Question: Identify the chart type used in this figure.
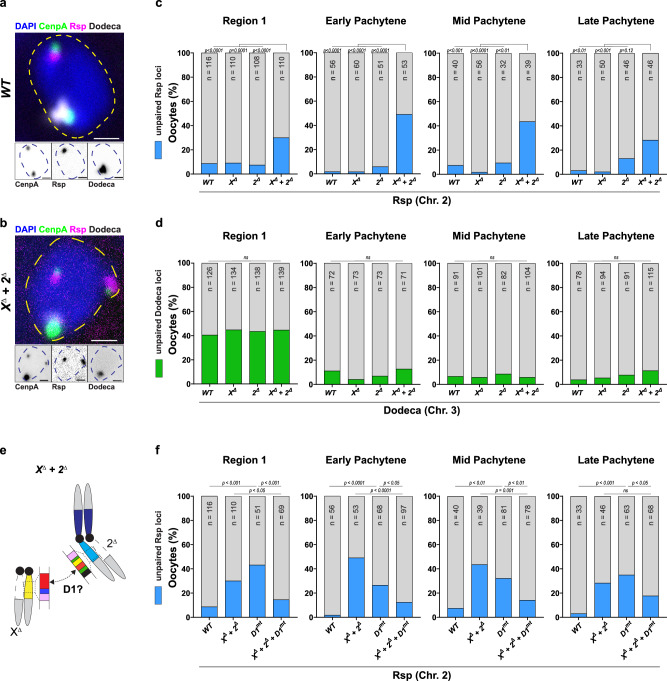
Answer: bar